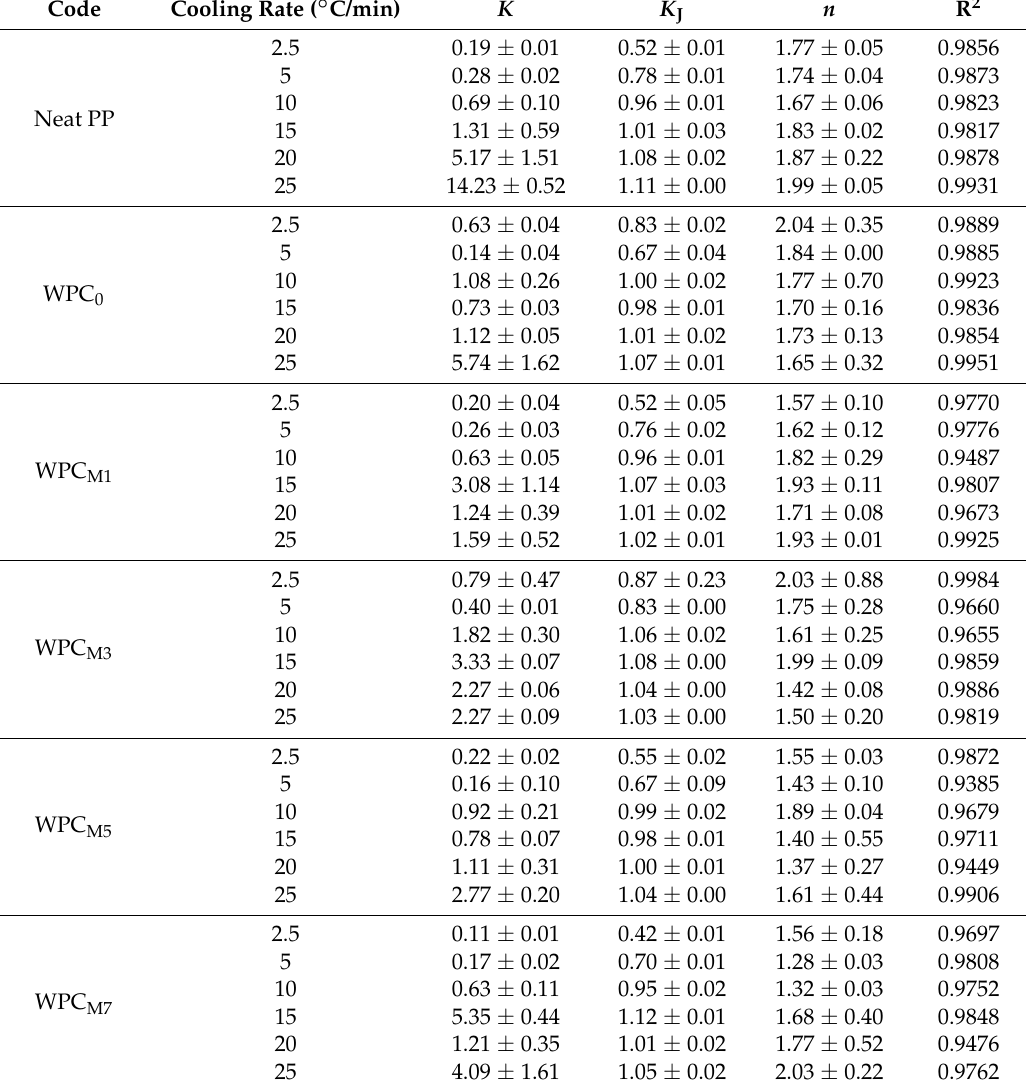
Table 2. The parameters calculated at various cooling rates based on the Avrami model.